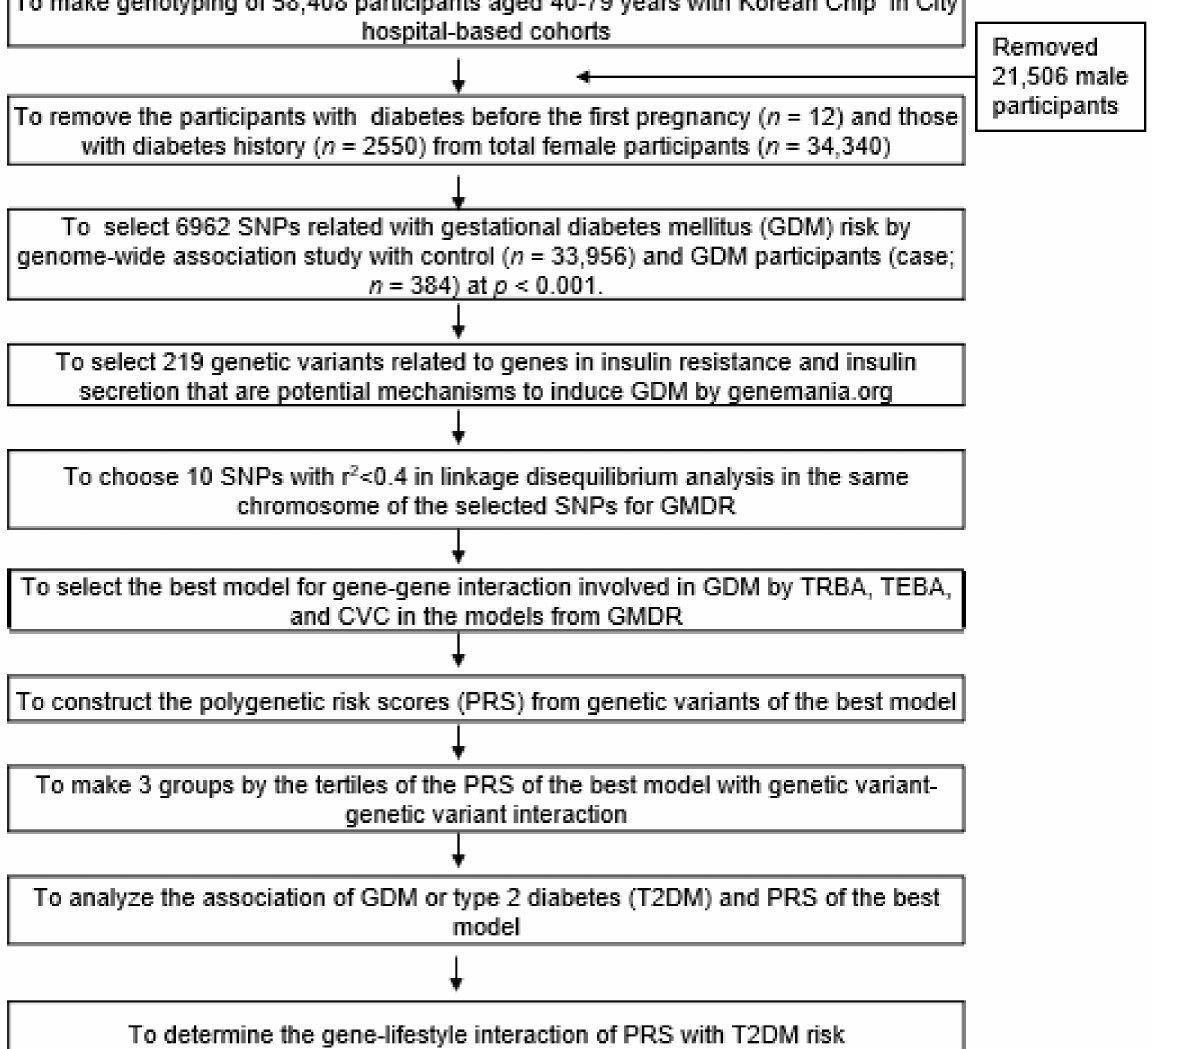
Figure 2. Flow chart to generate polygenetic variants in the best gene-gene interaction model for gestational diabetes mellitus (GDM) and their interaction with T2DM risk in later life. SNPs, single nucleotide polymorphisms; GMDR, Generalized Multifactor Dimensionality Reduction; TREB, trained balanced accuracy; TEBA, testing balanced accuracy; CVC, cross-validation